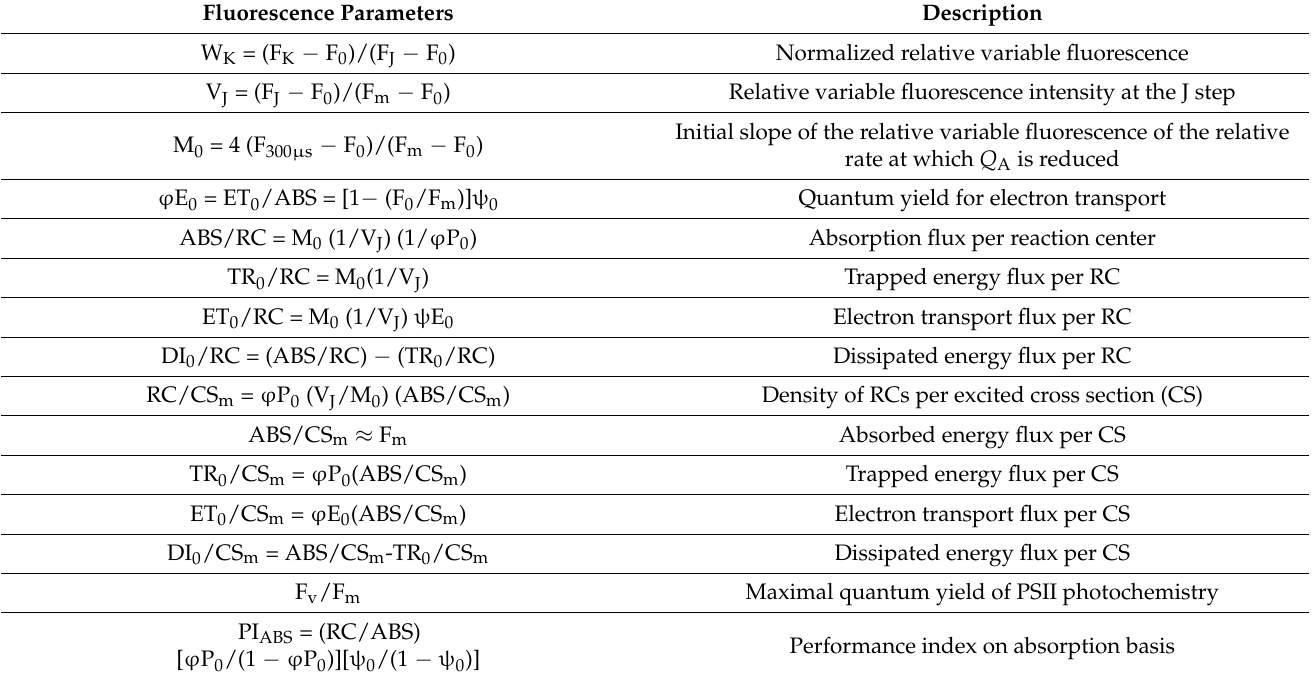
Table 4. Parameters in JIP test